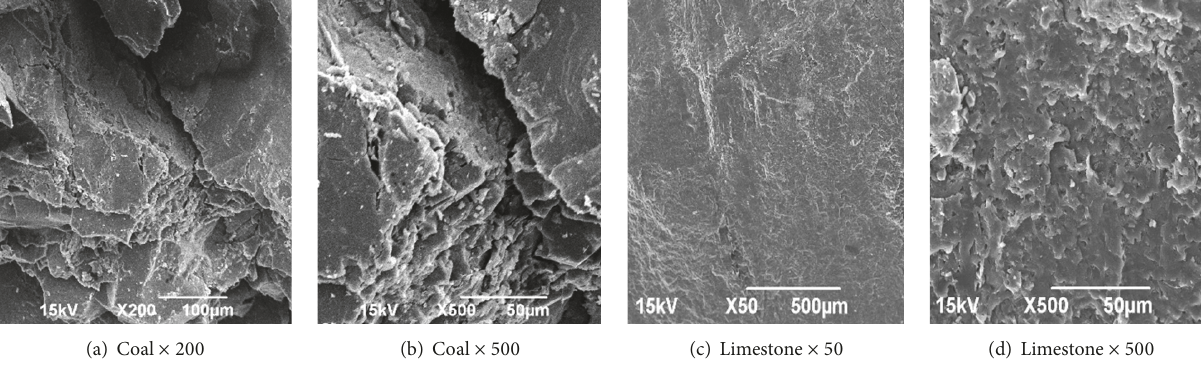
Figure 4: SEM testing photos of coal and Shendong limestone specimens.